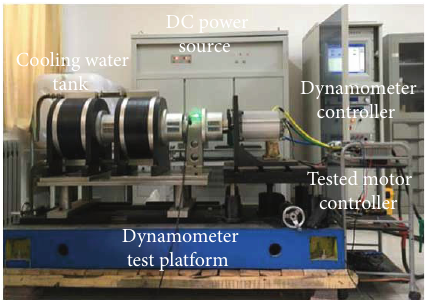
Figure 15: Dynamometer test platform.